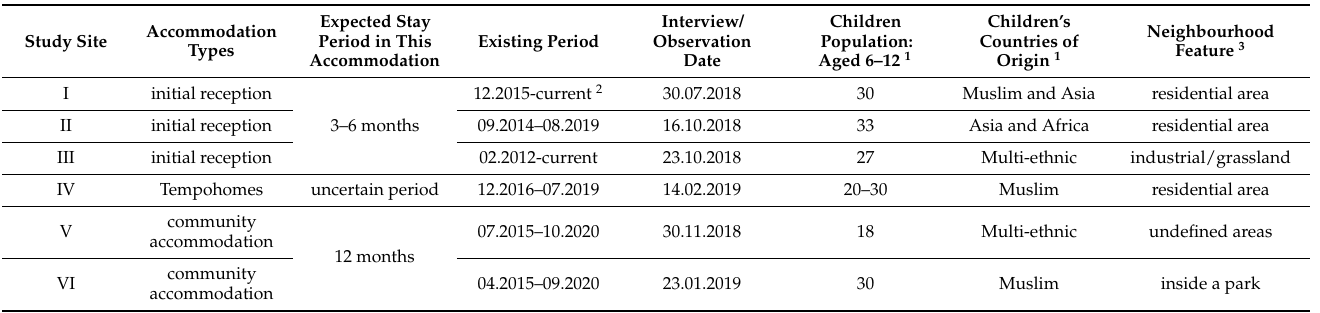
Table 1. Comparison of refugee accommodation features, children’s demographic information and neighbourhood features across six study sites.